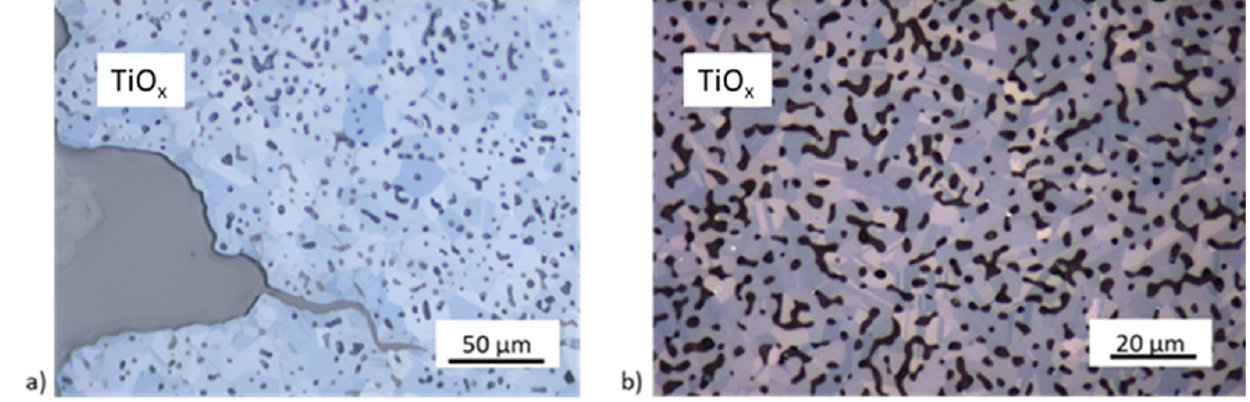
Figure 15. Twinning at a crack ( a ) and crack ‐ free TiO x substrate ( b ) .